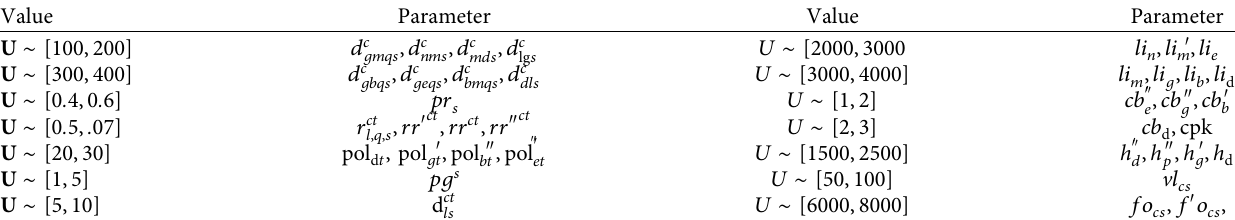
Table 3: Parameters of the numerical